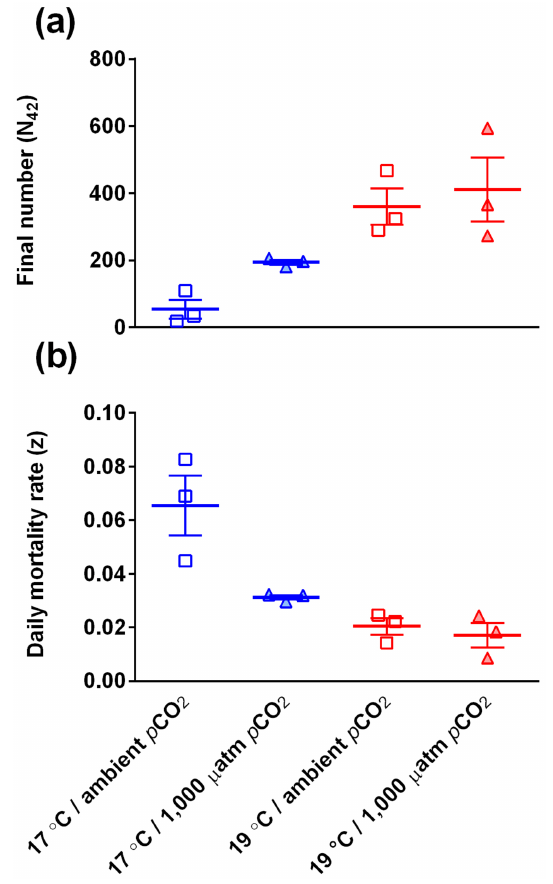
Fig. 2. (a) Final numbers and (b) daily mortality of D. labrax lar- vae after incubation for 42 days under each experimental condition. Data points are mean values for each experimental tank, horizontal lines are means and error bars are ± 1 standard error of the mean, SEM. See Table 1 for details on each experimental condition.